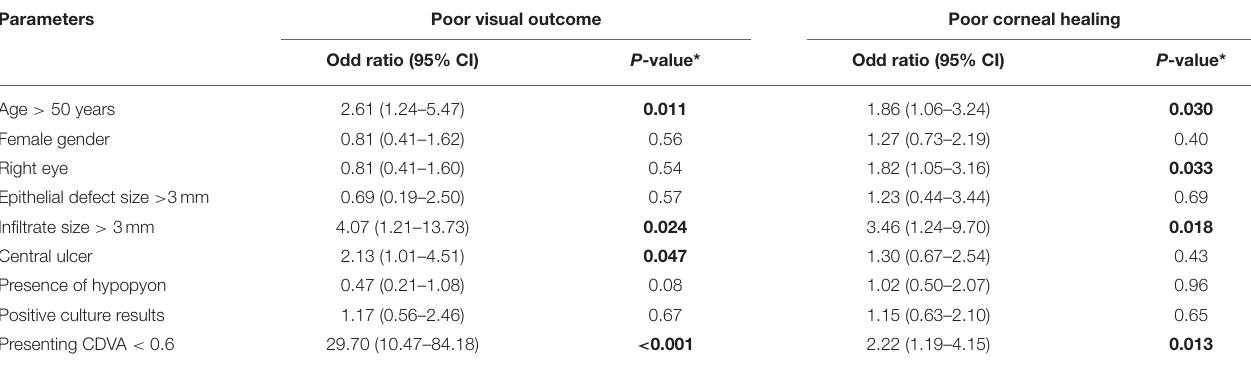
TABLE 4 | Prognostic factors for poor visual outcome [defined as corrected-distance-visual-acuity (CDVA) of < 0.60 logMAR] and poor corneal healing (defined as > 30 days to achieve complete healing or occurrence of corneal perforation or uncontrolled infection) in bacterial keratitis.